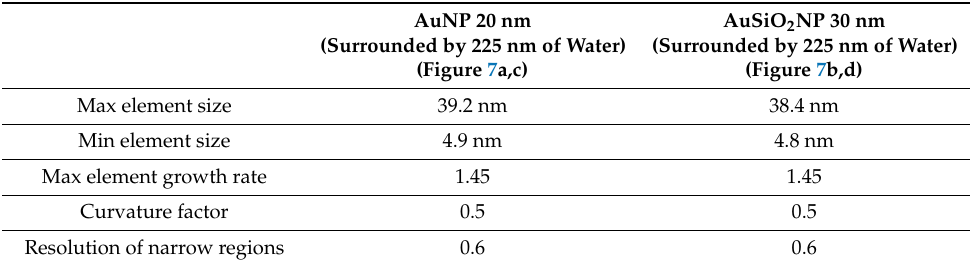
Table 3. Parameters of the meshes for the corresponding geometries of melanoma and prostate tumors.